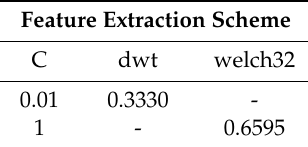
Table 10. Accuracy values for the case of SVM (linear kernel) in 10-fold cross-validation.